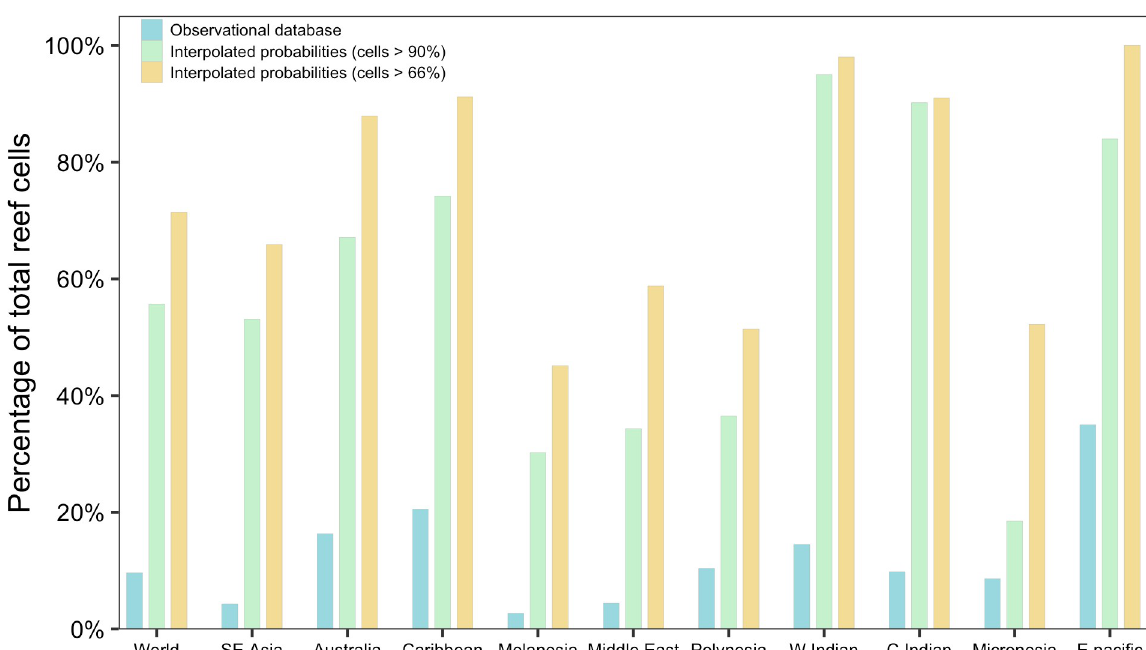
Fig 2. Percentage of coral cells by region with bleaching reports, > 90% bleaching probability and > 66% bleaching probability at least once during entire 1985–2017 period.